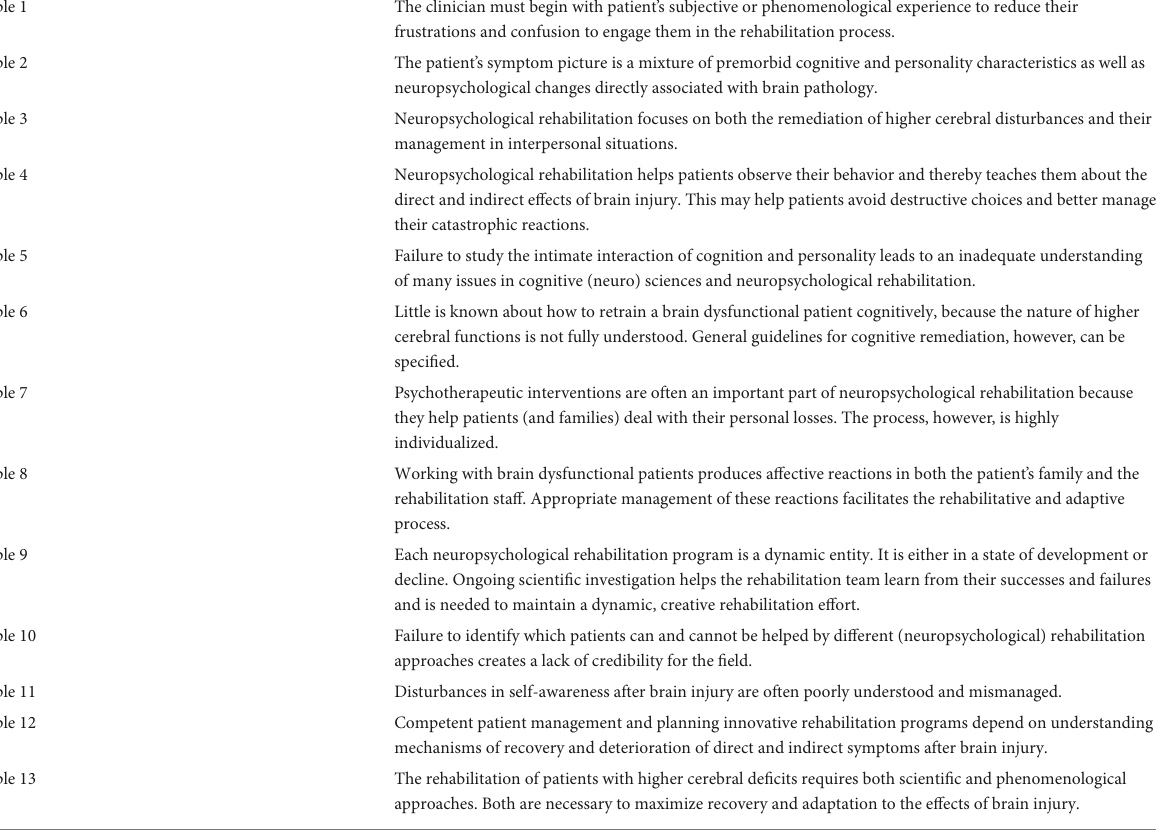
TABLE 1 Prigatano’s principles of neuropsychological